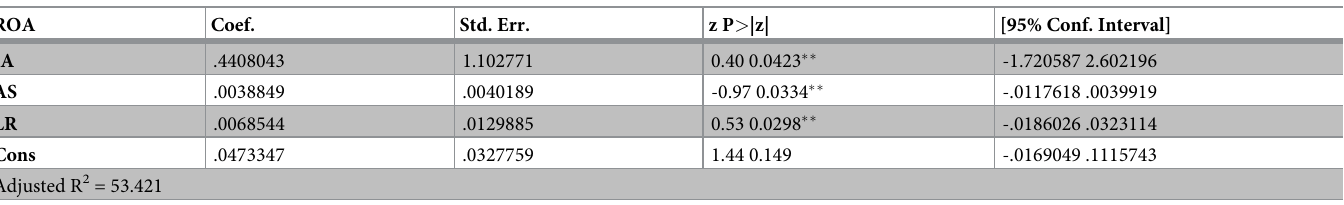
Table 6. Regression result -REM of Model